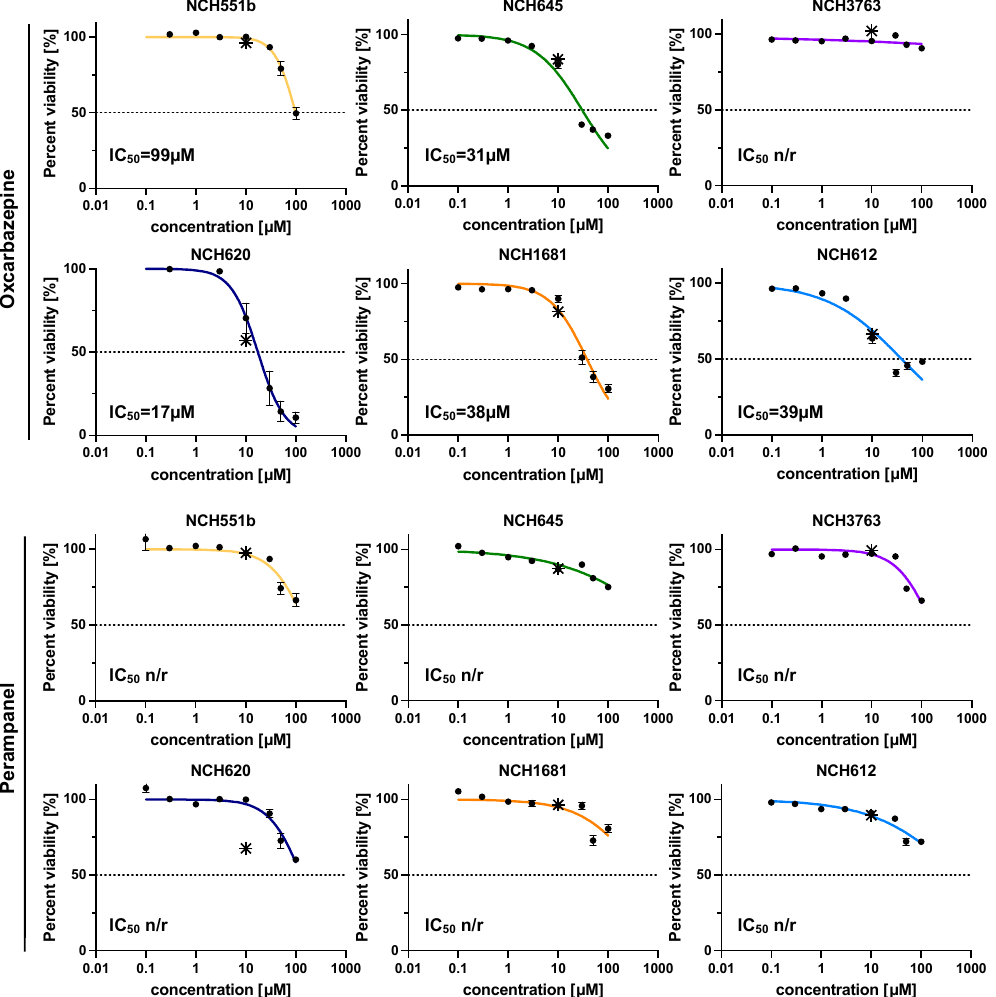
Figure 3. Dose–response curves for oxcarbazepine and perampanel in eight half-log concentration steps (0.1–100 µ M). Both AEDs showed a dose-dependent growth inhibition, with oxcarbazepine reaching the IC 50 in 5/6 IDH mut GSCs and the lowest IC 50 of 17.4 µ M in NCH620. Perampanel induced a dose-dependent growth inhibition but did not reach the IC 50 in the range of concentrations tested. The experiments were performed in biological and technical triplicates. * depicts the percent of cell viability in the initial drug screen (10 µ M); n/r = not